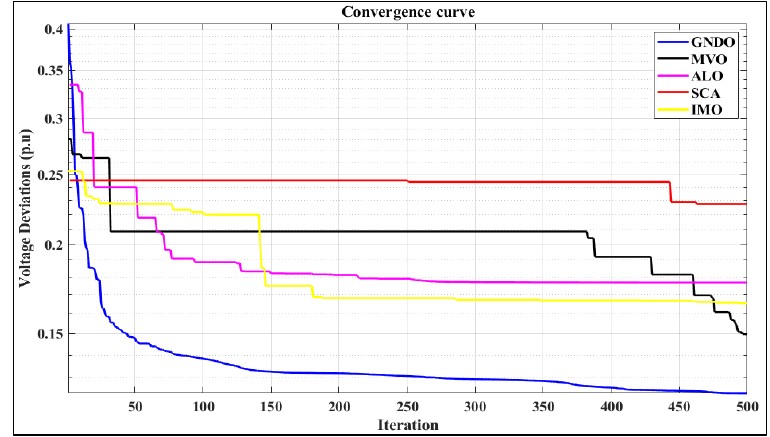
Figure 15. Convergence characteristics of voltage deviation minimization.